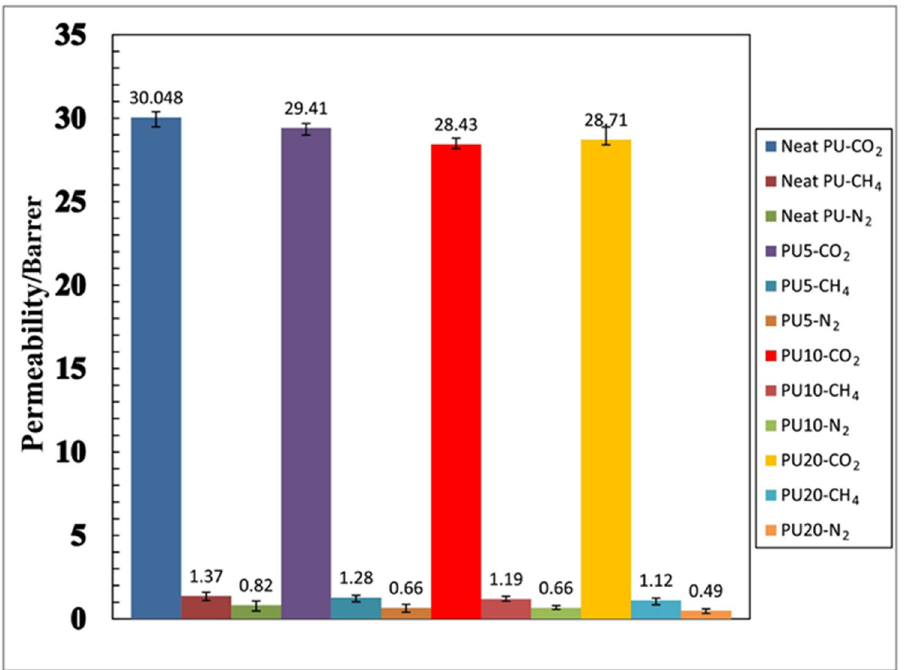
Figure 4. Effect of SAPO-34 content in the gas permeation properties of polyurethane–SAPO-34 membranes on the permeability of CO 2 , CH 4 , and N 2 gases in 1.2 MPa pressure and selectivity of CO 2 /CH 4 and CO 2 /N 2 gases in 1.2 MPa pressure. Adapted with permission from Ref. [94]. Copyright 2019 Elsevier.